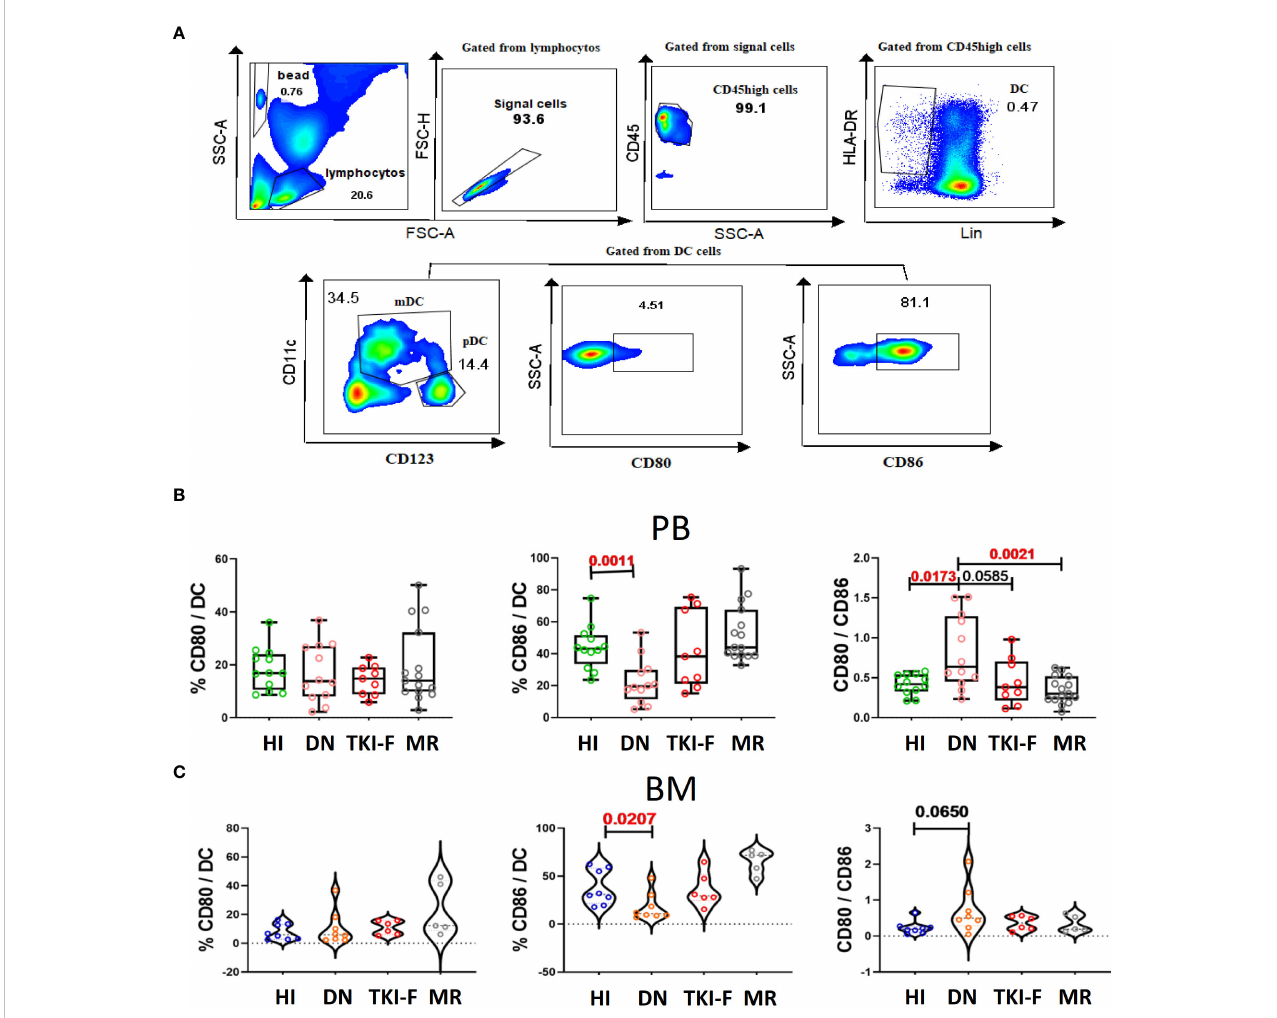
FIGURE 4 PB and BM DCs cells from DN-CML patients express a lower percentage of CD86 and with an unbalance CD80/CD86 ratio. (A) Gating strategy to identify DCs cells and the expression of CD80/CD86 on DCs cells. The CD45 high population was used to eliminate immature cells, and then HLA-DR + and Lin - (CD3, CD19, CD56, CD14 and CD16) was used to identify that DCs. CD80 + and CD86 + were further used to gate CD80 + DCs and CD86 + DCs cells. (B) The frequency of CD80 + DC, CD86 + DC, and CD80/CD86 ratio in PB (B) and BM (C) of HIs (PB, n = 12, BM, n = 8) and DN-CML (PB, n = 12, BM, n = 8), TKI-F (PB, n = 9, BM, n = 6), and MR (PB, n = 17, BM, n = 5) patients. The P values shown are from the Mann-Whitney U test between